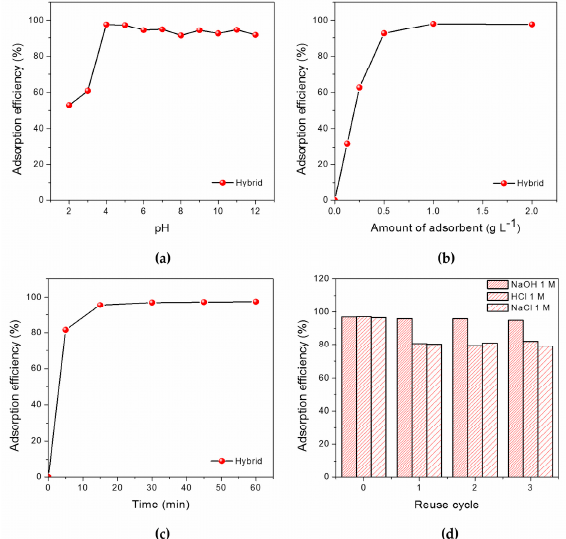
Figure 4. Evaluation of the adsorption efficiency of the sepia melanin-P(E- alt -MA) hybrid ( a ) as a function of pH; ( b ) as a function of the adsorbent’s amount; ( c ) as a function of time; ( d ) as a function of reuse cycle with different desorbing agents. All data shown are the average of three independent measurements, the relative standard deviation being ≤ 10%. The lines are a guide for the eye.